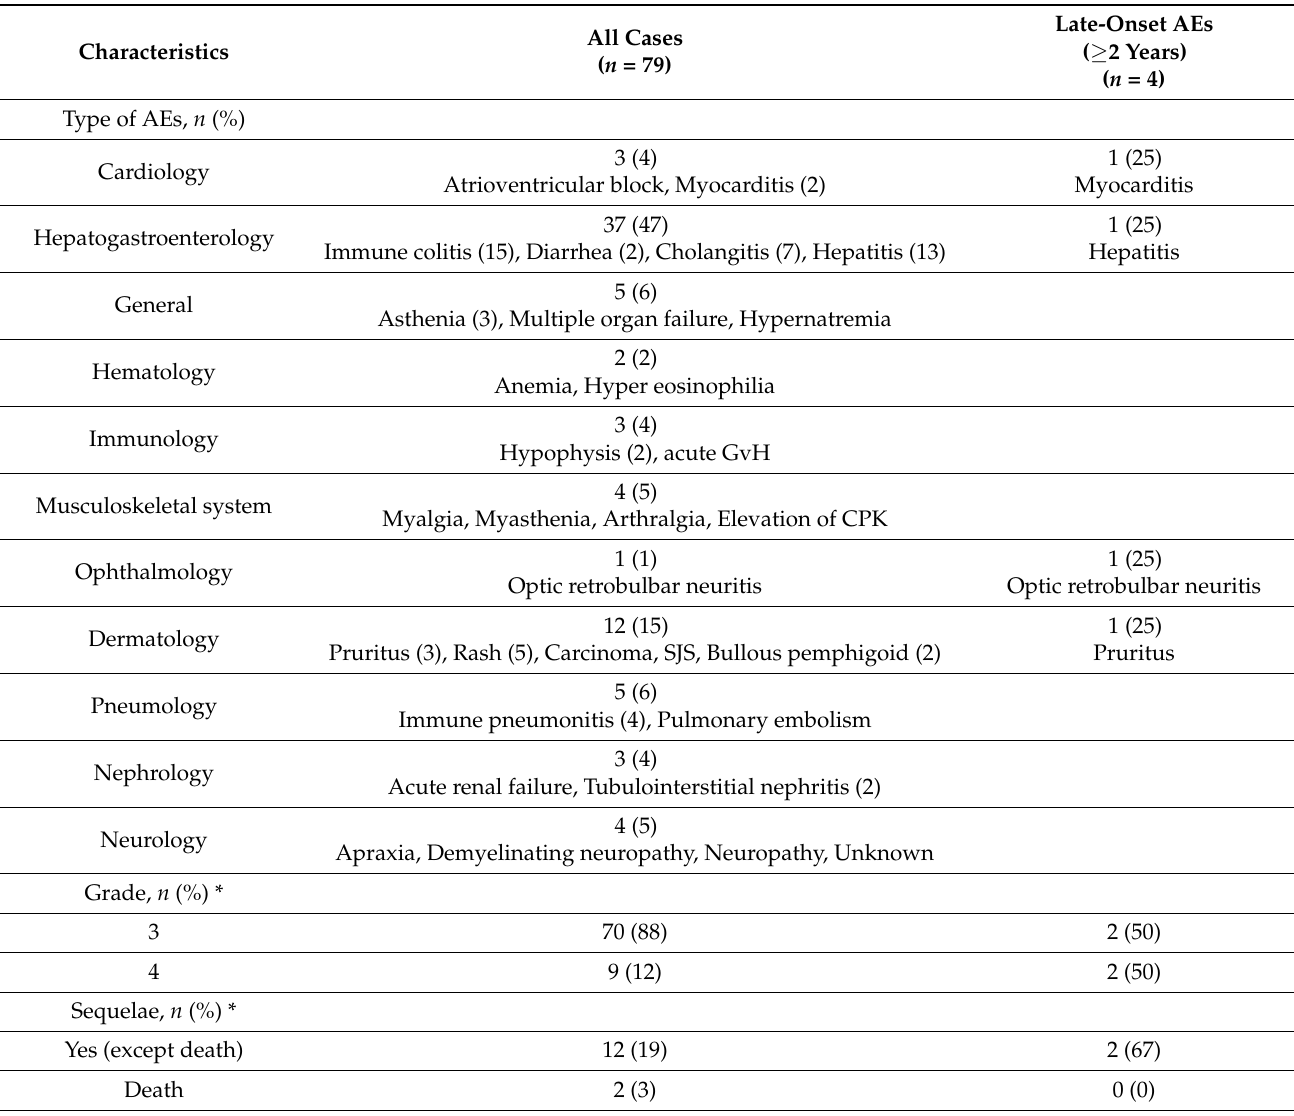
Table 2. Characteristics and consequences of